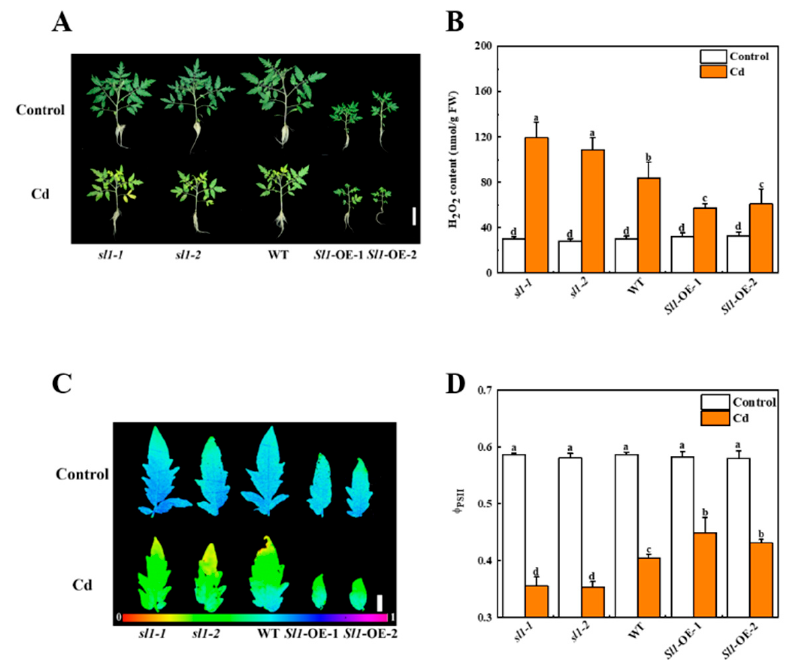
Figure 3. Sl1 positively regulates tomato Cd tolerance. ( A ) The phenotype of Sl1 mutant lines ( sl1-1/2 ), wild-type (WT), and Sl1 overexpressing lines ( Sl1 -OE-1/2) under control and Cd stress after 15 d treatment. Bar = 10 cm. ( B ) The content of hydrogen peroxide (H 2 O 2 ) in the roots of Sl1 mutant lines ( sl1-1/2 ), WT, and Sl1 overexpressing lines ( Sl1 -OE-1/2) under control and Cd stress after 3 d treatment. ( C , D ) the image and level of actual quantum efficiency of PSII photochemistry ( Φ PSII ) of sl1-1/2 , WT, and Sl1 -OE-1/2 plants with and without Cd treatment for 15 d. Bar = 1 cm. The data presented here are the average of three biological replicates ( ± SD). Different letters indicate a significant difference ( p < 0.05, Tukey’s